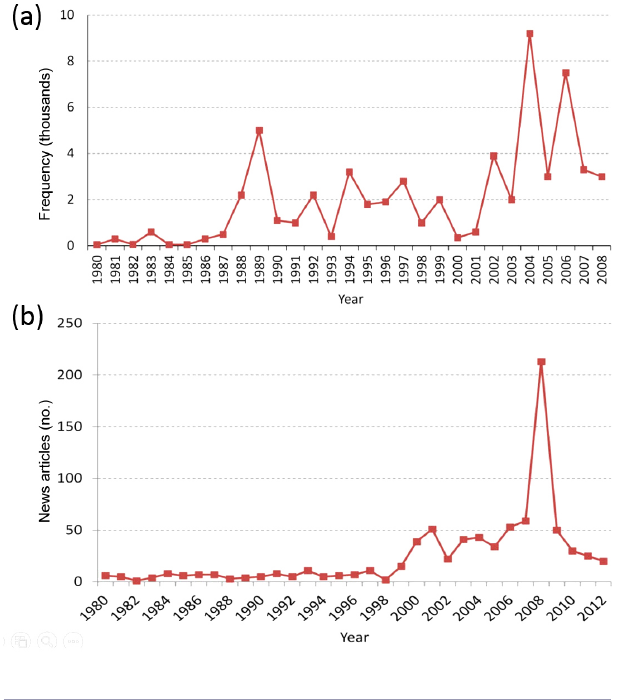
Fig. 4 . (a) Temporal changes in the frequency of the words “Wolong Nature Reserve” in published English books (unsmoothed) between 1980 and 2008. (b) Number of international news articles containing the words “Wolong Nature Reserve” and published in the English language from 1980 to 2012, as documented using the LexisNexis® Academic search